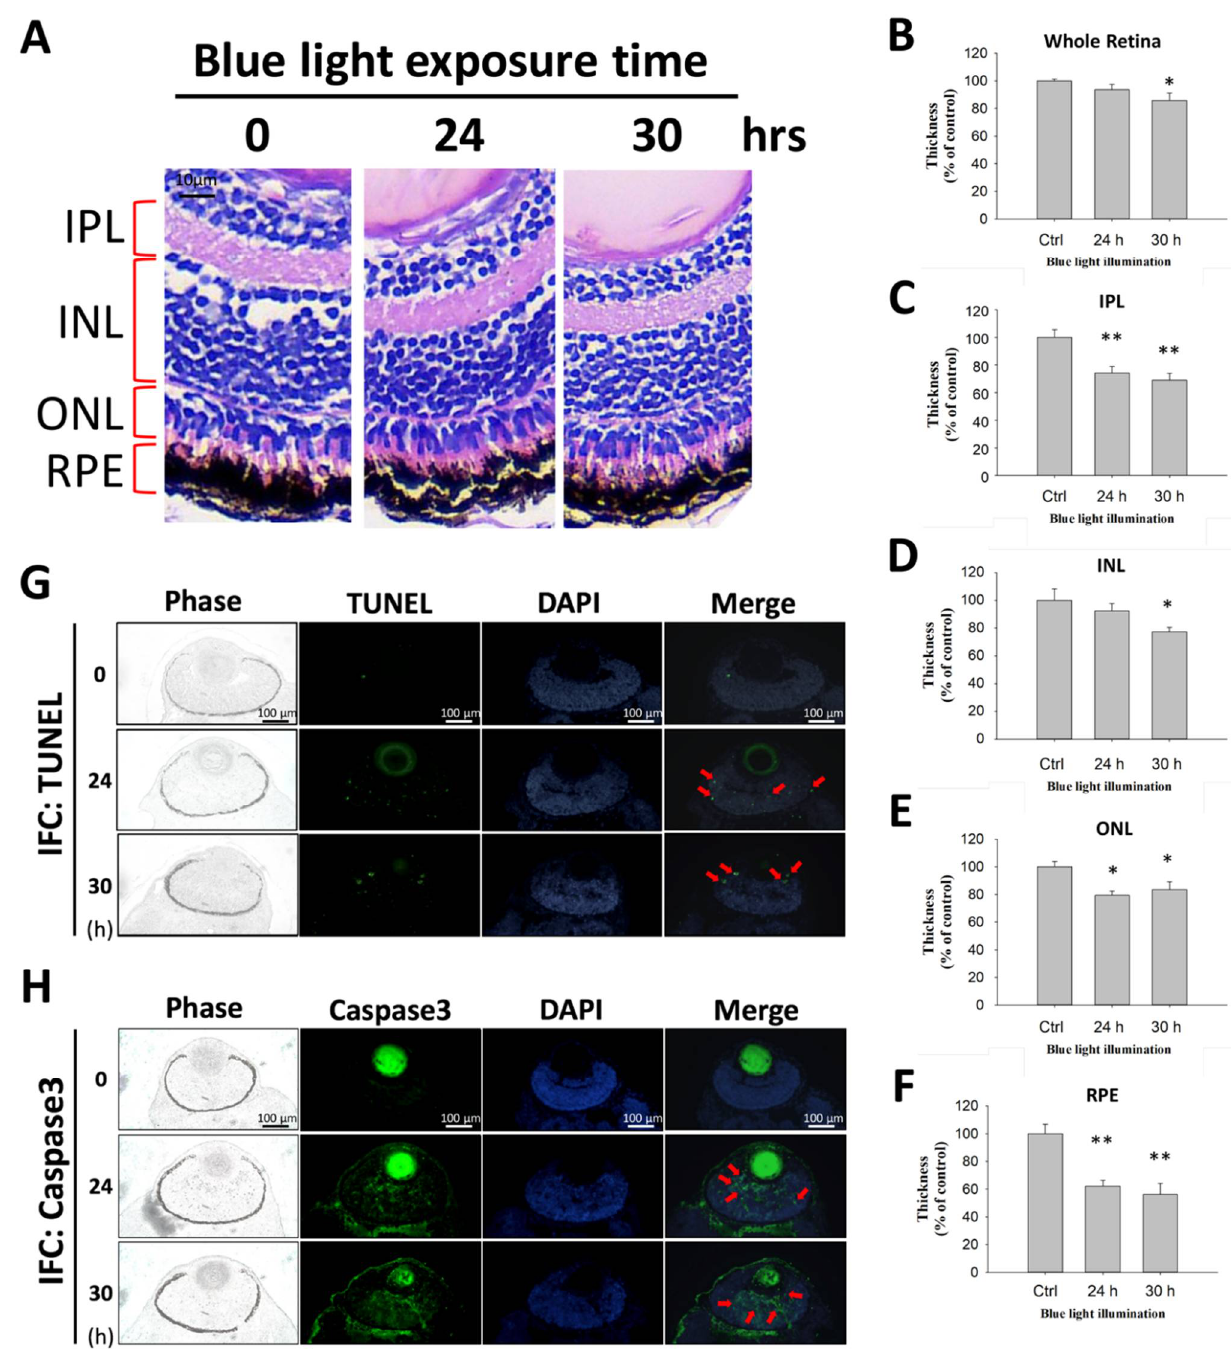
Figure 5. Effect of blue light in the regulation of retinal tissue development in a zebrafish larvae model. ( A ) Retinal tissue sections with HE staining determined the retinal-related layer distribution, including the IPL (inner plexiform layer), INL (inner nuclear layer), ONL (outer nuclear layer), and RPE (retinal pigment epithelium) layers. Blue light exposure times of 24 and 30 h were compared with the 0 h control group. The quantitative thickness results of individual layers, including ( B ) the whole retina, ( C ) IPL, ( D ) INL, ( E ) ONL, and ( F ) RPE layer, were compared to determine the effect of blue light on retinal tissue development (* p < 0.05, ** p < 0.01). ( G ) TUNEL assay of blue light-exposed zebrafish retinal tissue. Phase: bright-field, Green: TUNEL reaction, Blue: DAPI for nuclear staining. Zebrafish exposed to blue light for 0, 24, and 30 h. ( H ) Retinal tissue of blue-light-exposed zebrafish used for the apoptosis immunofluorescence determination marker caspase-3. Green: Caspase-3 expression.